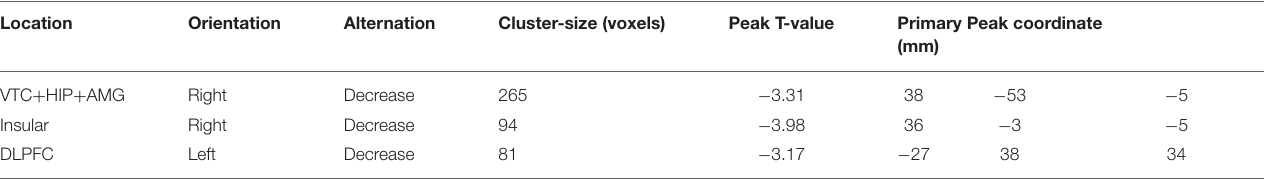
TABLE 2 | Compared with HW, ANDP patients have decreased ReHo regions.